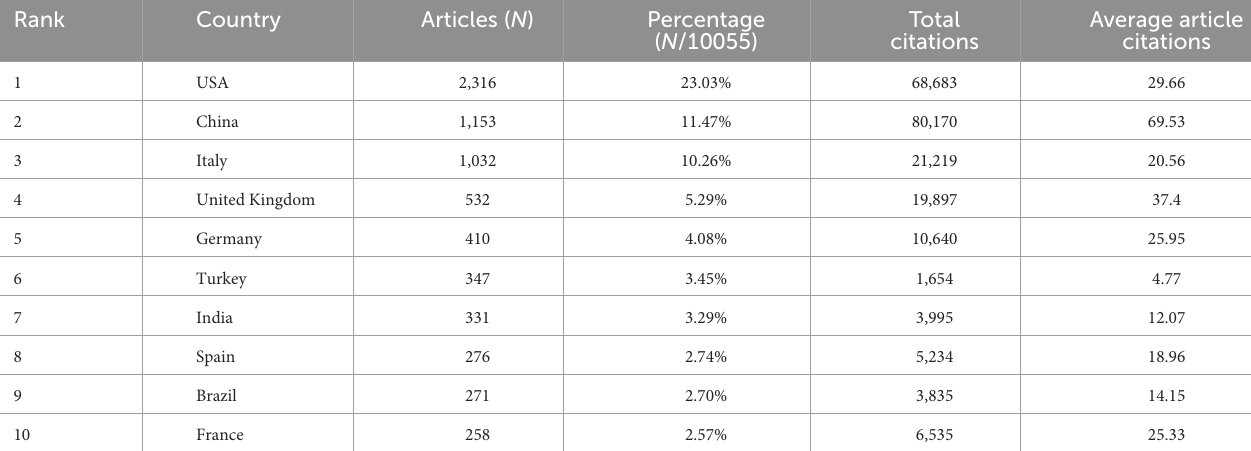
TABLE 1 Top 10 most productive countries/regions for COVID-19-related CVD